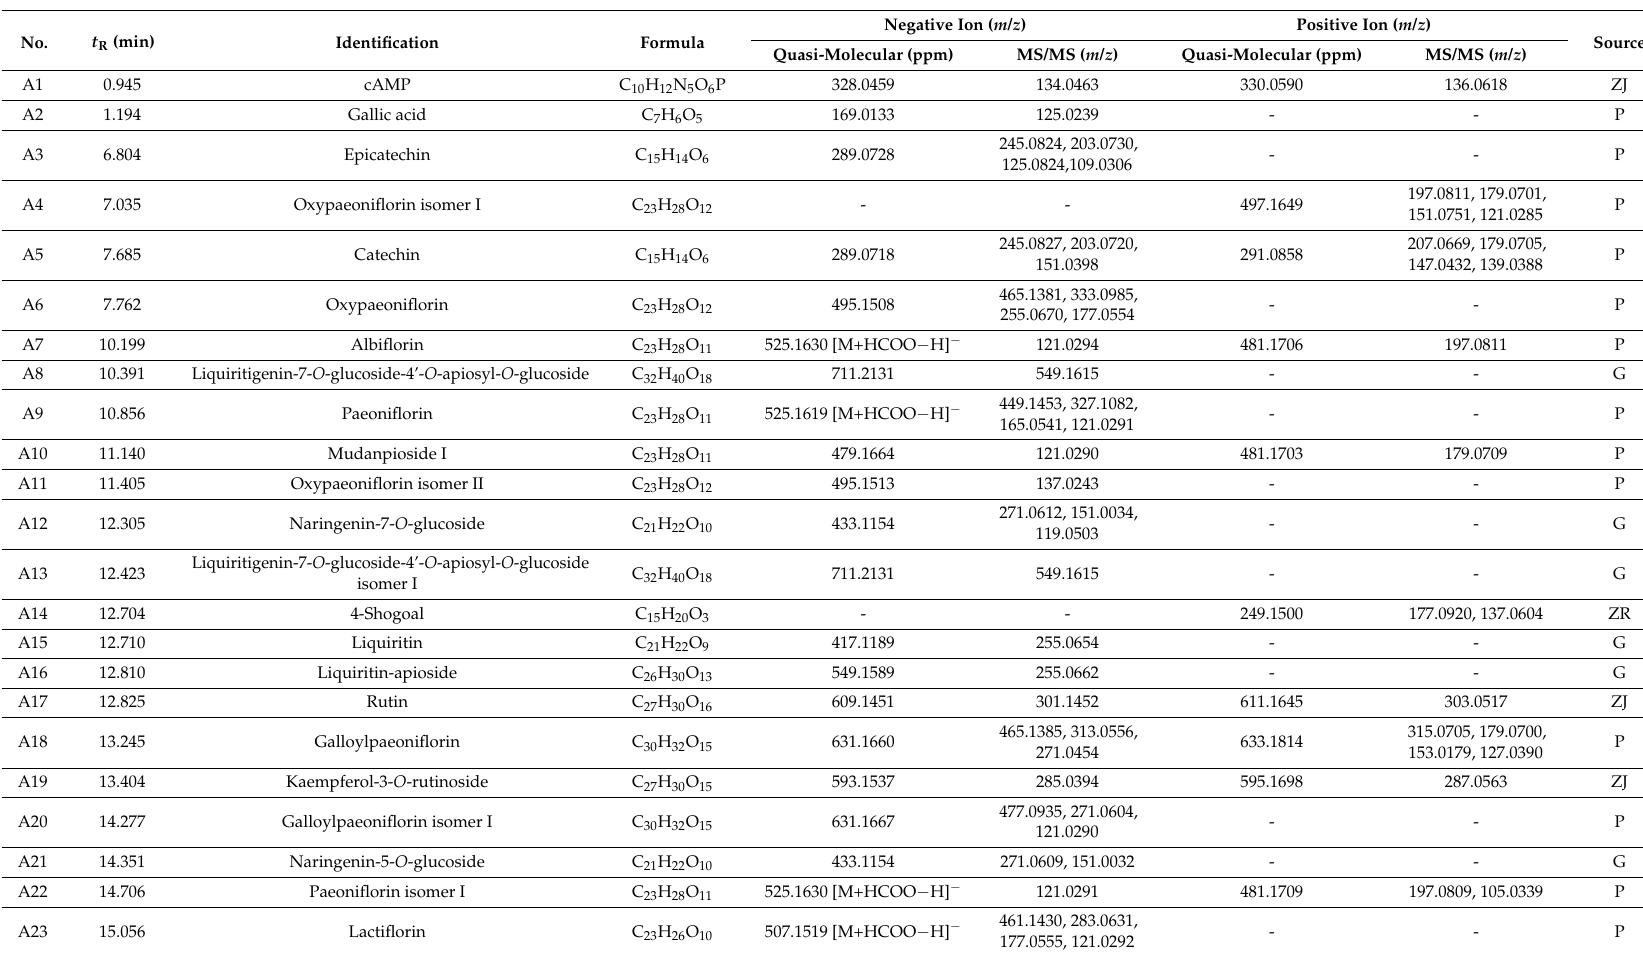
Table 1. Identification and detection of chemical compounds of Guizhi decoction (GZD) by rapid resolution liquid chromatography with quadrupole-time-of-flight mass spectrometry